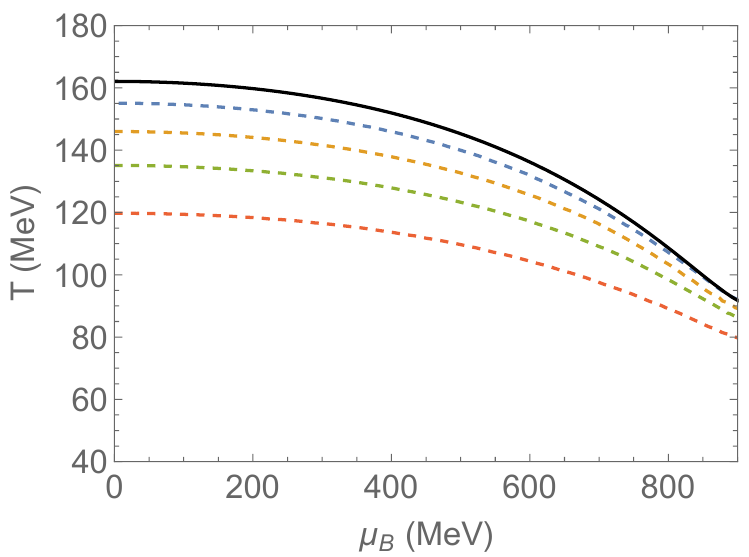
Figure 3. Iso-occupancy contour lines, T ξ ( µ B , ξ ) , for hadronic matter in the statistical bootstrap model with excluded volume. The dashed lines show the contours for the occupation fractions ξ = 0.8,0.6,0.4, and 0.2 (top to bottom). The solid black line corresponds to T ξ ( µ b ,1 ) = T c ( µ B ) , also shown in Figure 1. The hadrochemical horizon identified by the valence-quark percolation threshold is expected to lie between the orange ( ξ = 0.6) and blue ( ξ = 0.8) dashed